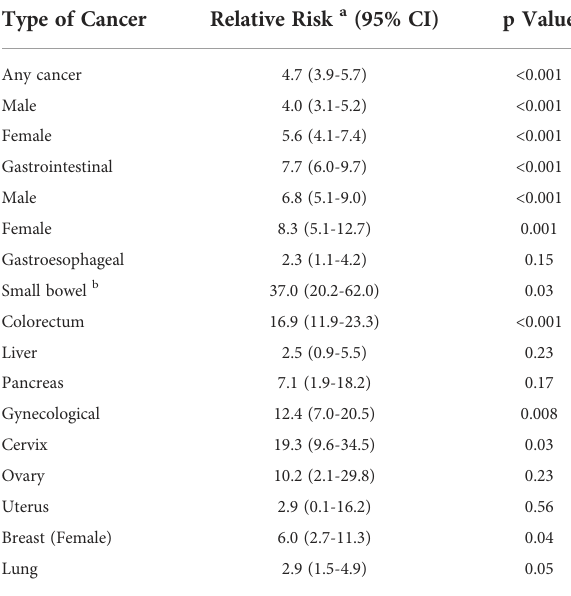
TABLE 4 Relative cancer risk by site and gender in PJS patients compared to general Chinese population. Type of